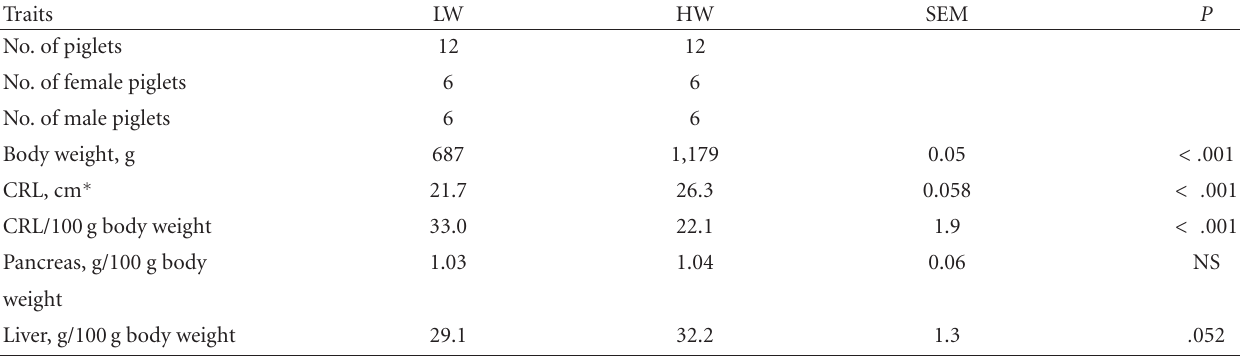
Table 1: Anatomical characteristics of low birth weight (LW) and high birth weight (HW) piglets. LSMean values and standard errors of the LSMeans (SEM) are